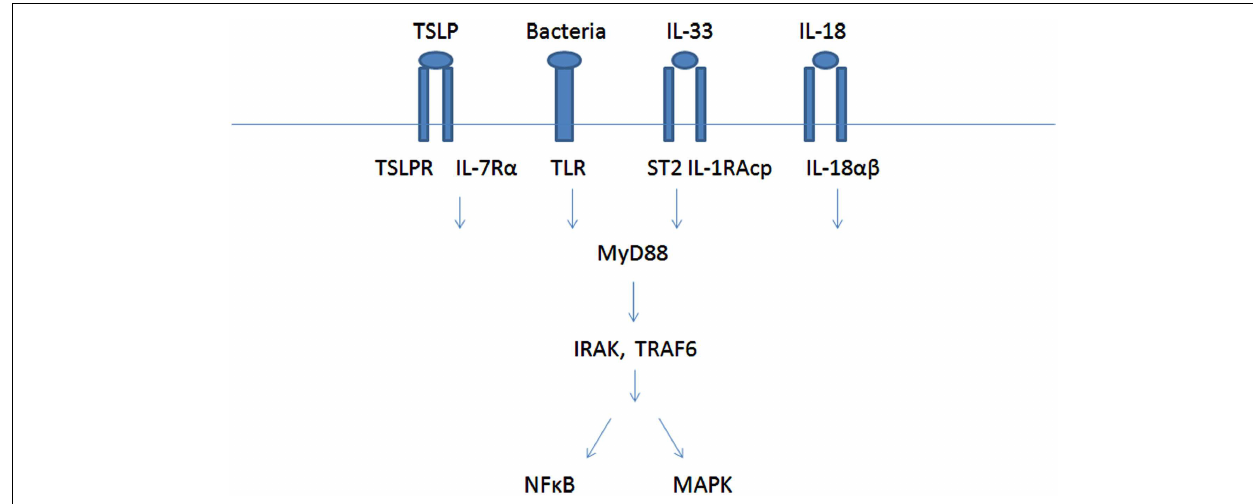
FIGURE 1 | Mast cells co-activation by IL-18, IL-33,TSLP, andTLR receptors.